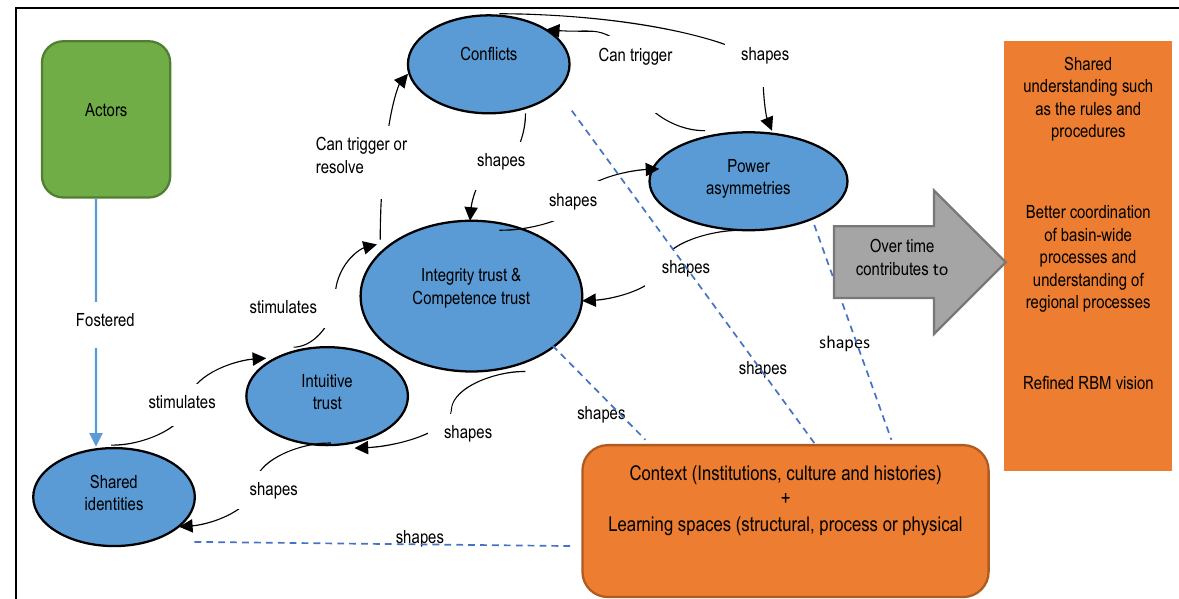
Fig. 4 Learning space in the Zambezi basin. Shows interaction of trust, shared identities and learning spaces in the Zambezi basin (source